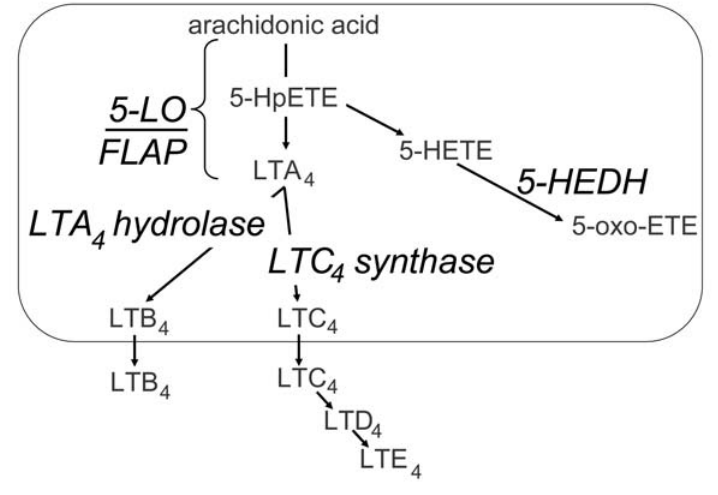
FIGURE 3. The 5-LO pathway. The synthesis of LTs from AA is initiated by 5-LO and FLAP, with LTA 4 hydrolase and LTC 4 synthase completing the production